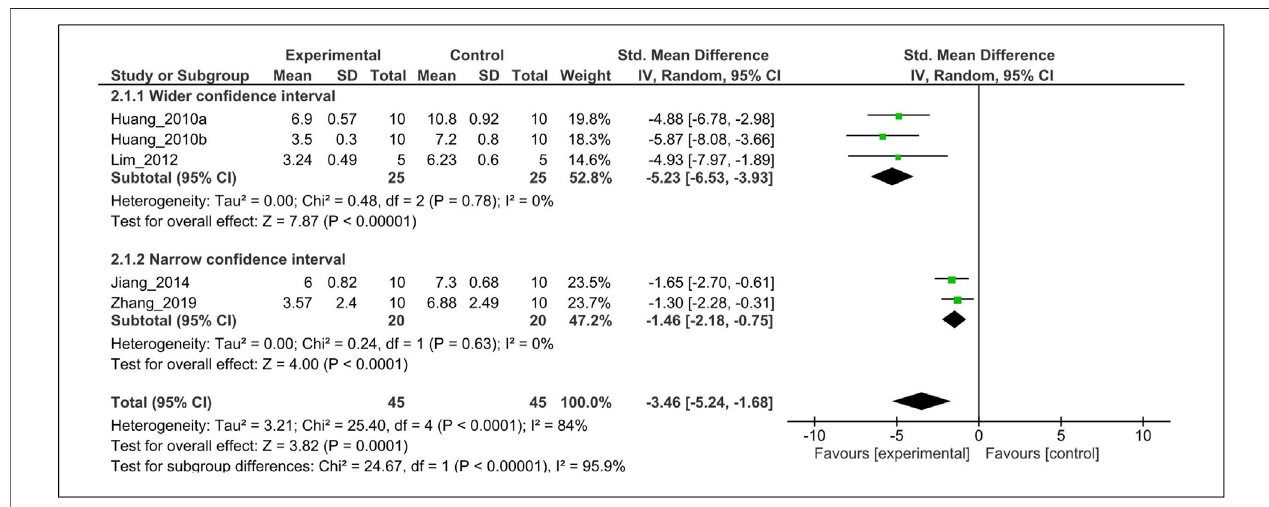
FIGURE 7 | Subgroup analysis of histological score strati fi ed according to the wide 95% CI versus narrow 95% CI. The test for subgroup differences showed a statistically signi fi cantsubgroup effect ( p < 0.00001), indicatingthatthe wide95%CIsubgroup produced largereffects. Furthermore,there isnoheterogeneitybetween the trials within each of these subgroups (wider-CI: I 2 (cid:1) 0%; narrow-CI: I 2 (cid:1) 0%). CI, con fi dence interval; SD, standard deviation; IV, independent